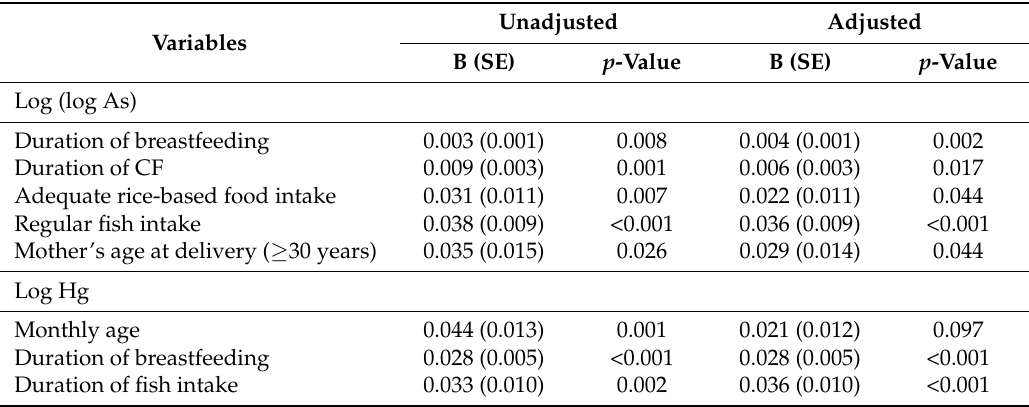
Table 5. Simple and multiple linear regression analysis of Log (log As) and Log Hg levels in 210 infants according to demographics, dietary parameters, and iron status.